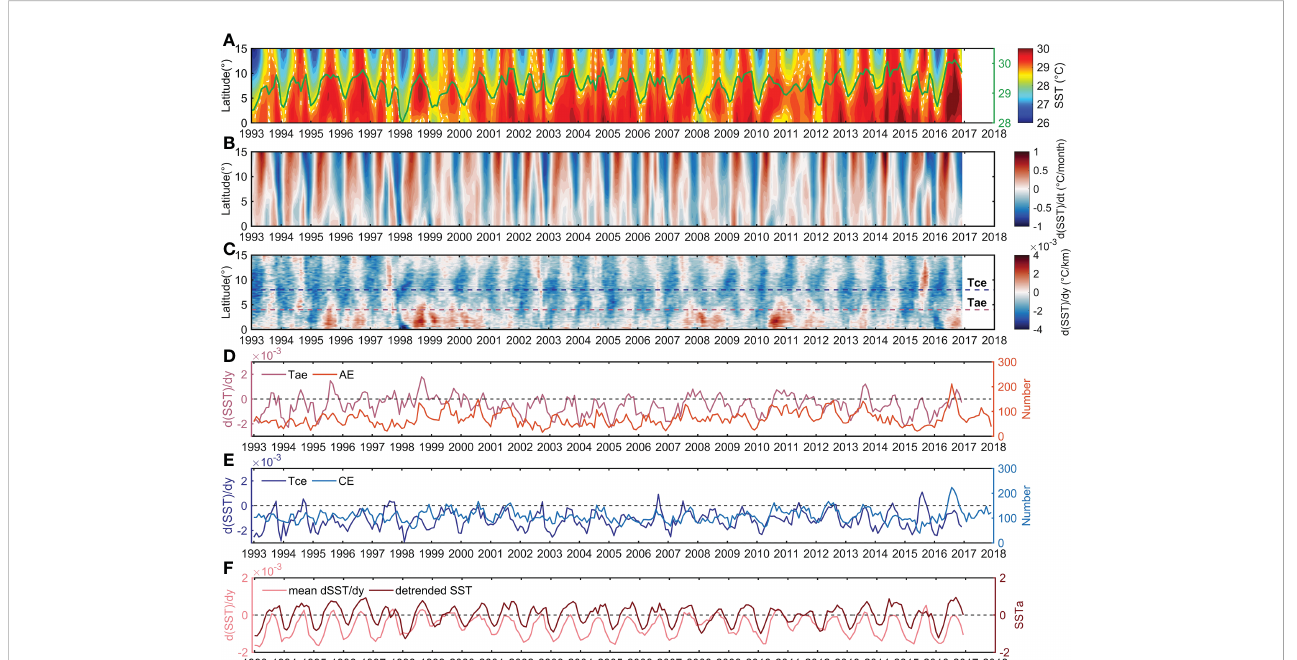
FIGURE 7 Time series of the zonal-averaged (A) SST, (B, C) temporal and meridional gradients of SST, (D, E) comparison of typical transects (eddy belt region) of SST gradients and ME number, and (F) comparison of the mean meridional gradients of the SST and the detrended SST in this tropical region. The green line in (A) indicates the average value of [0° – 7.5° N; 125° – 180° E], and white dash line indicates the contour of 28.93°C. The transects Tae and Tce in (C – E) indicate the meridional gradients of SST in CE and AE belts,